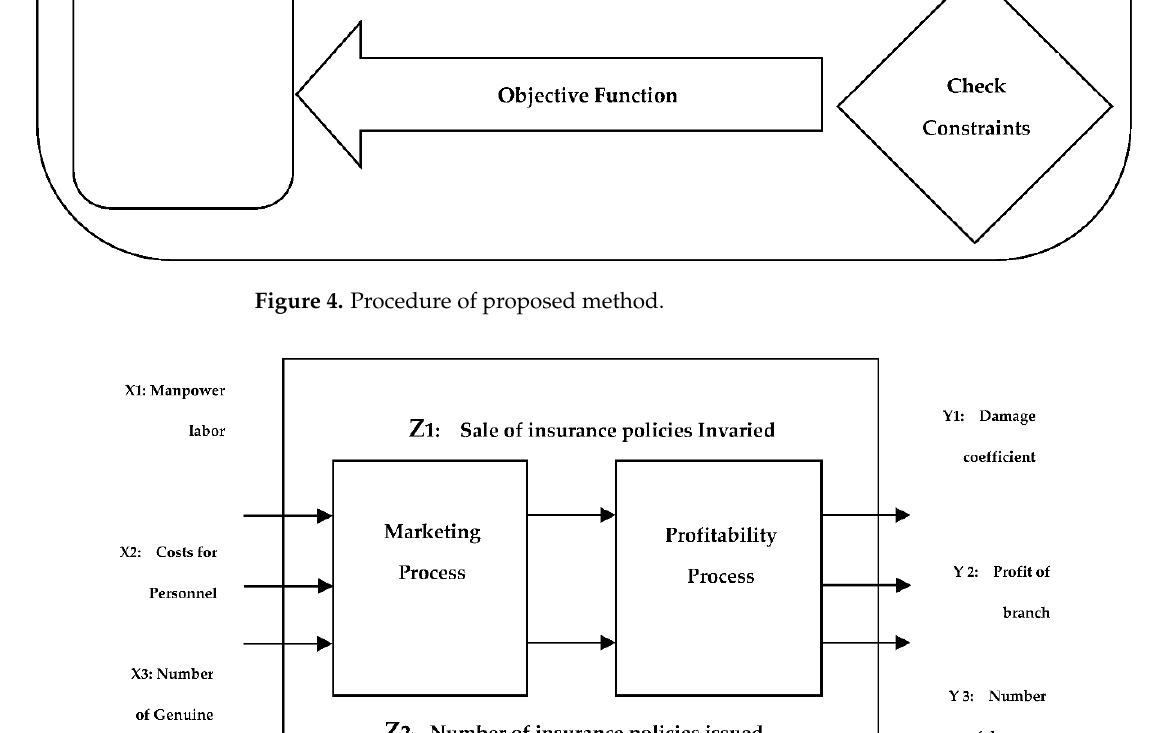
Figure 5. The proposed two stages of the DEA model.